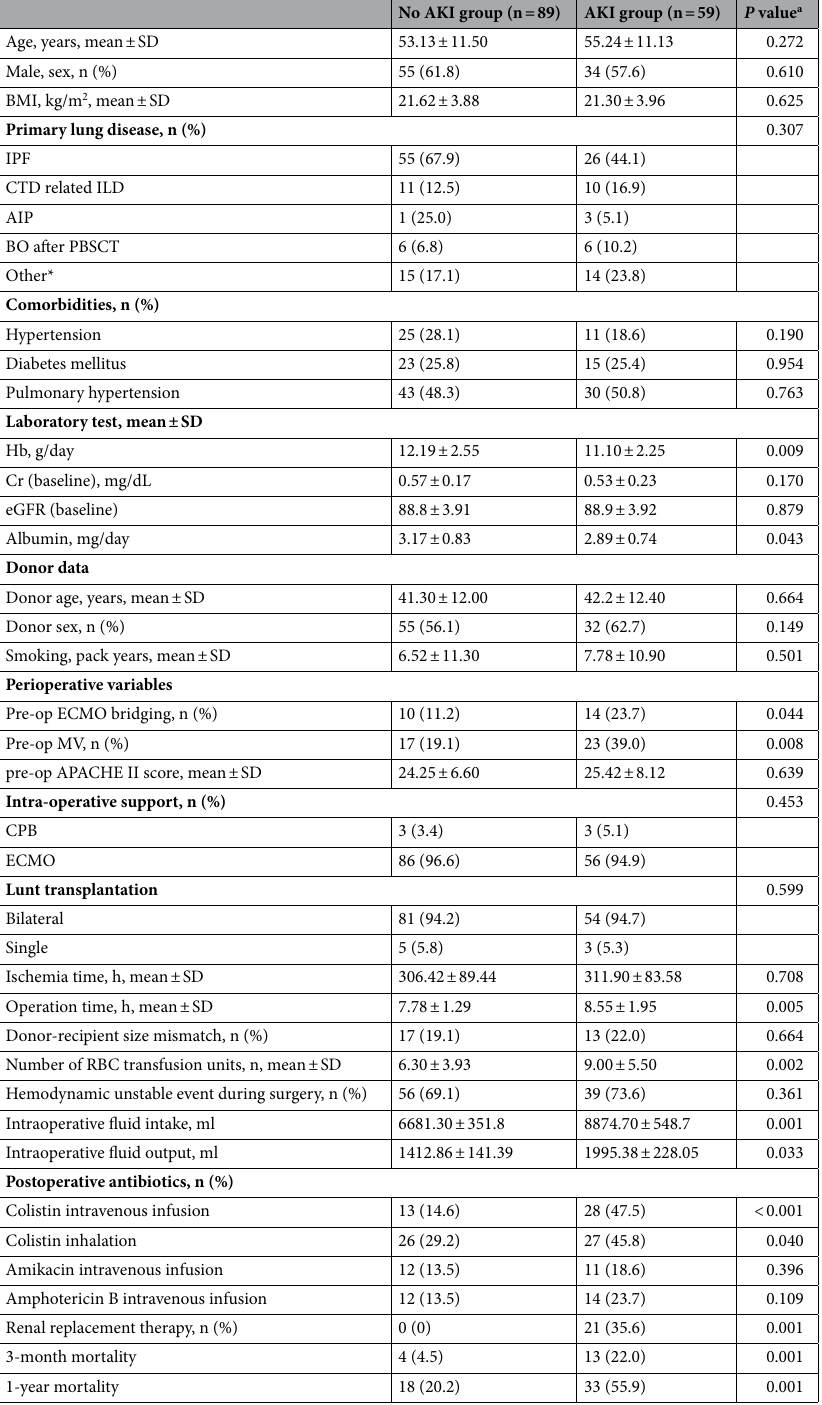
Table 1. Baseline characteristics of 148 recipients according to acute kidney injury within 1 month after lung transplantation. Data are presented as numbers (%) or means ± standard deviation (SD). BMI